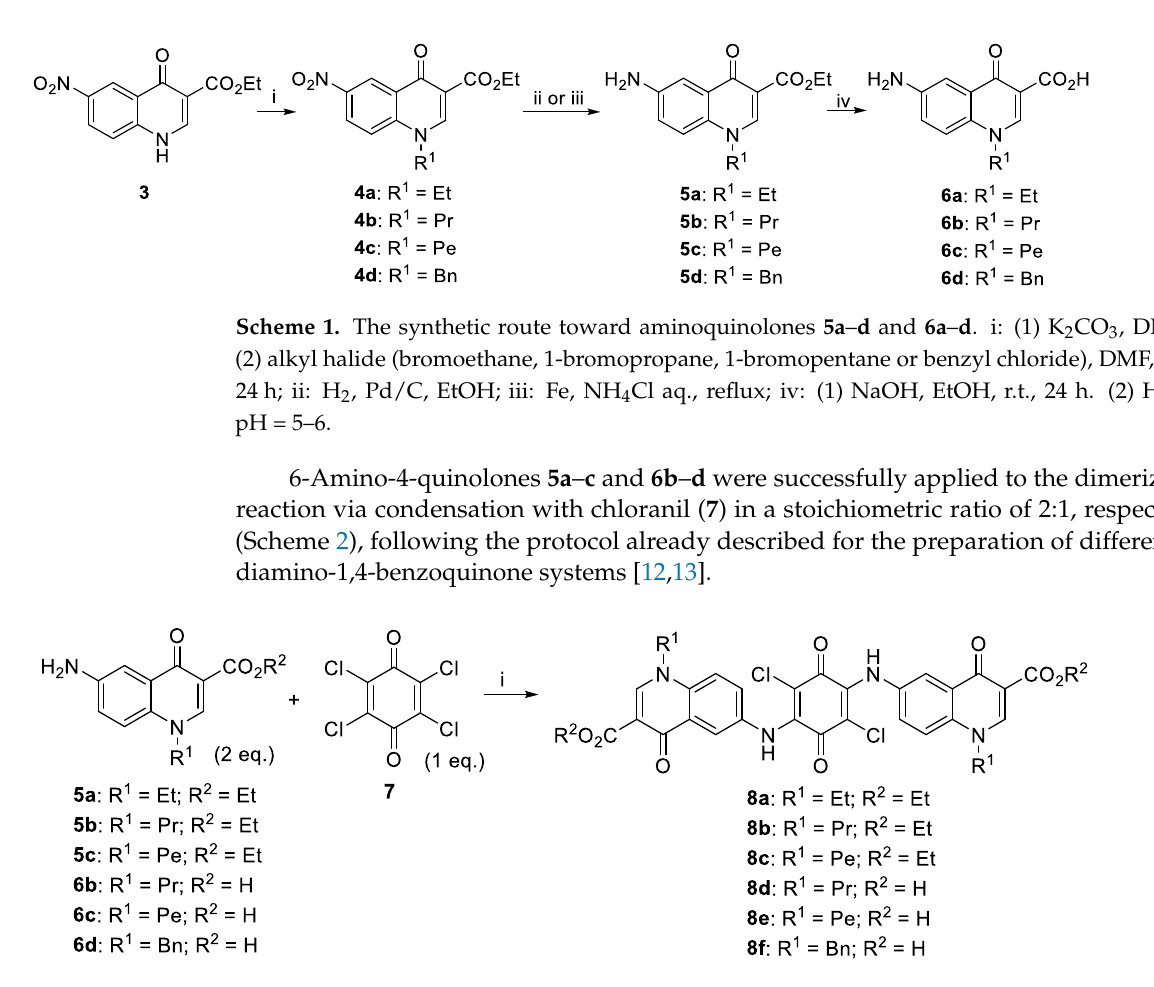
Figure 2. 4-Quinolone motif and possible intermolecular interactions with biomolecules. ( a ) π - π Stacking interactions. ( b ) Chelating property with biometals. ( c ) Hydrogen bonds.